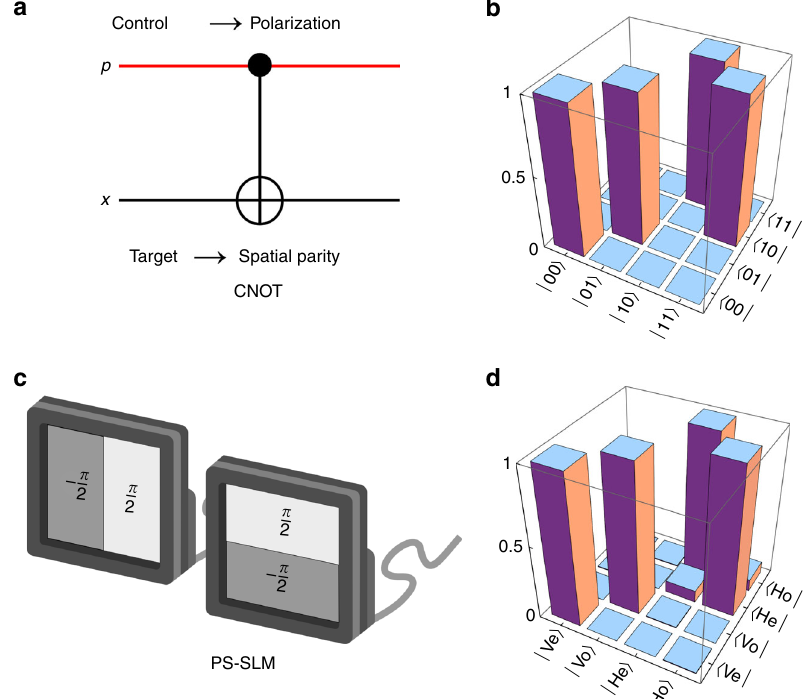
Fig. 3 A polarization-sensitive spatial light modulator as a single-photon CNOT gate. a Quantum circuit of a CNOT gate and b the corresponding operator represented in the logical basis 0 j i ; 1 j if g . c Physical realization of a CNOT gate in polarization-parity space with a spatial light (cid:3) 0 j i ; 1 j if g control target modulator (SLM). The SLM imparts a phase step π between the two halves of the plane along either x or y and thus acts as a parity fl ipper when the control qubit (polarization) is on. d The corresponding operator represented in the V j i ; H j if g control (cid:3) e j i ; o j if g basis target